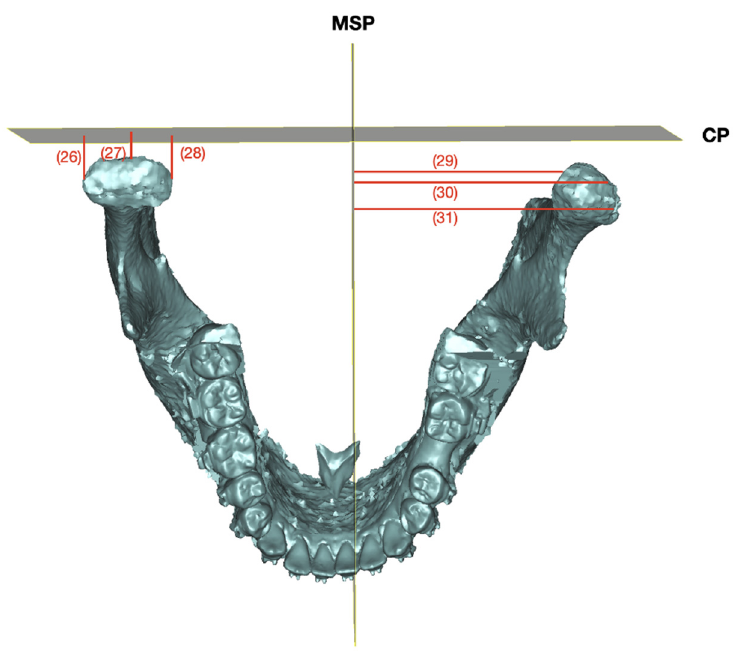
Figure 7. Mandibular condyle position measurements. (26) Medial condylar pole to CP, (27) Co to CP, (28) lateral condylar pole to CP, (29) medial condylar pole to MSP, (30) Co to MSP, (31) lateral condylar pole to MSP.